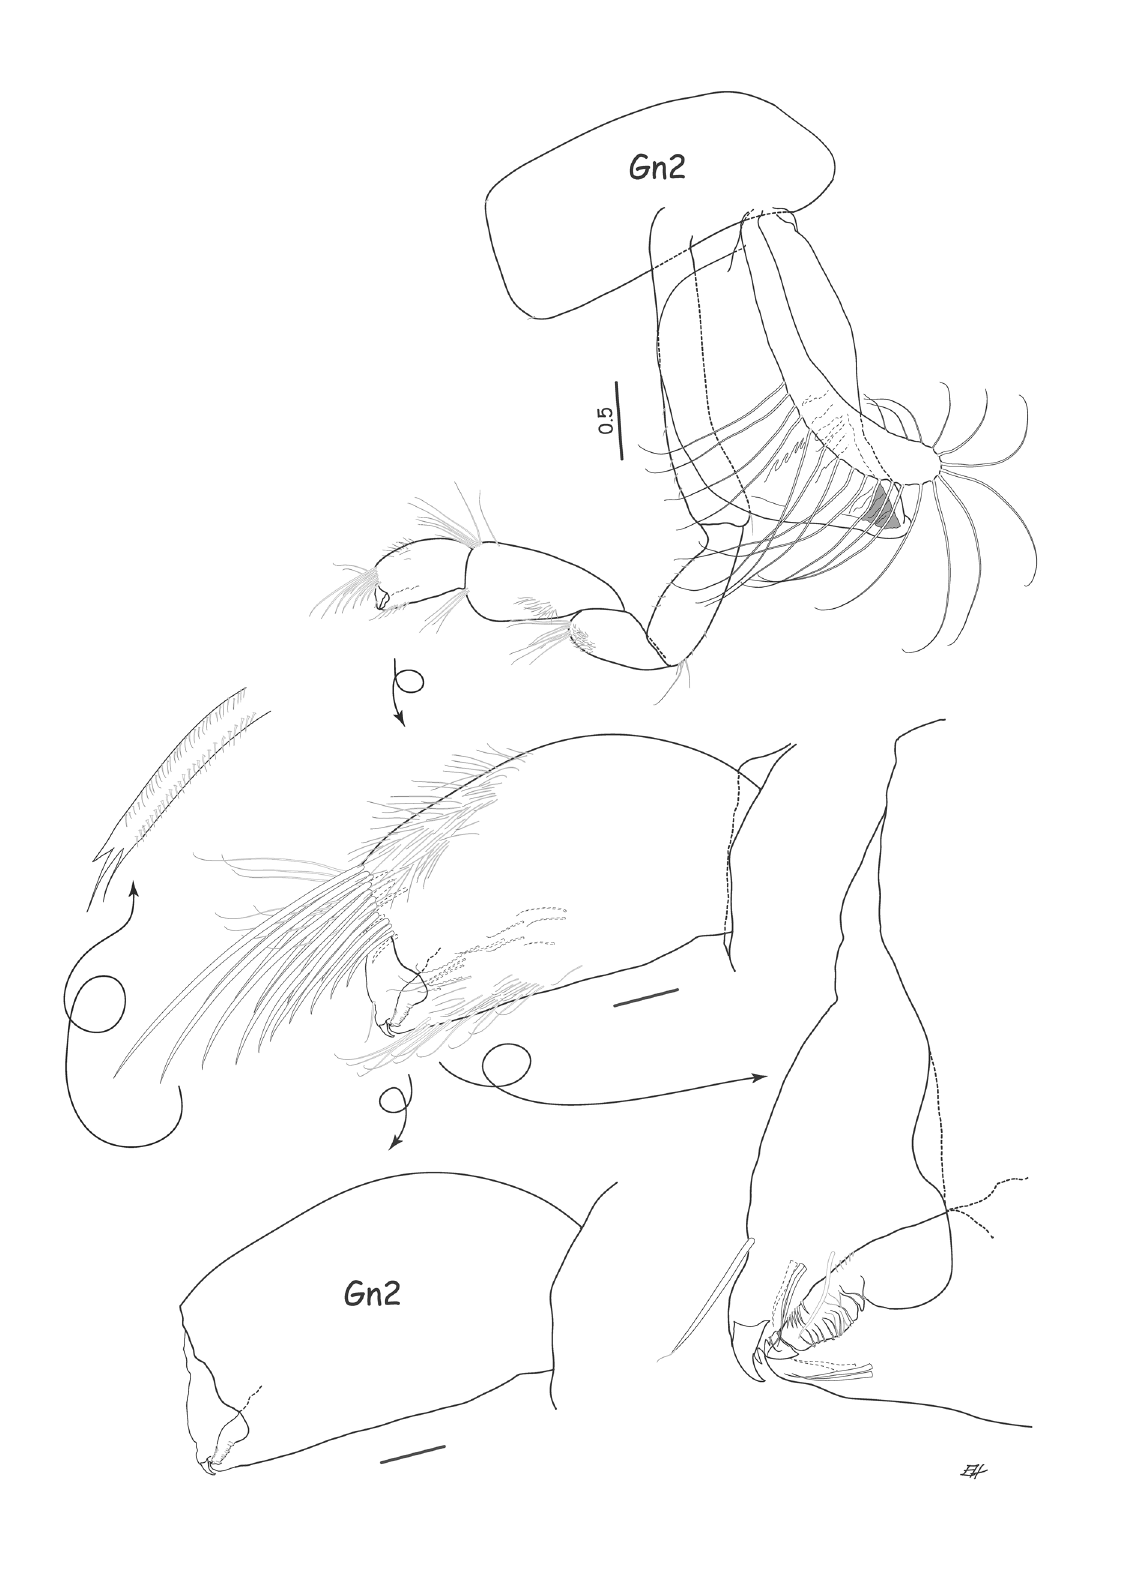
Fig. 15. Abyssorchomene patriciae sp. nov., holotype, ♀, 10.5 mm (NHM UK 2022.6). Setae omitted on Gn2 propodus outline and dactylus detail. Scale bars = 0.1 mm unless indicated